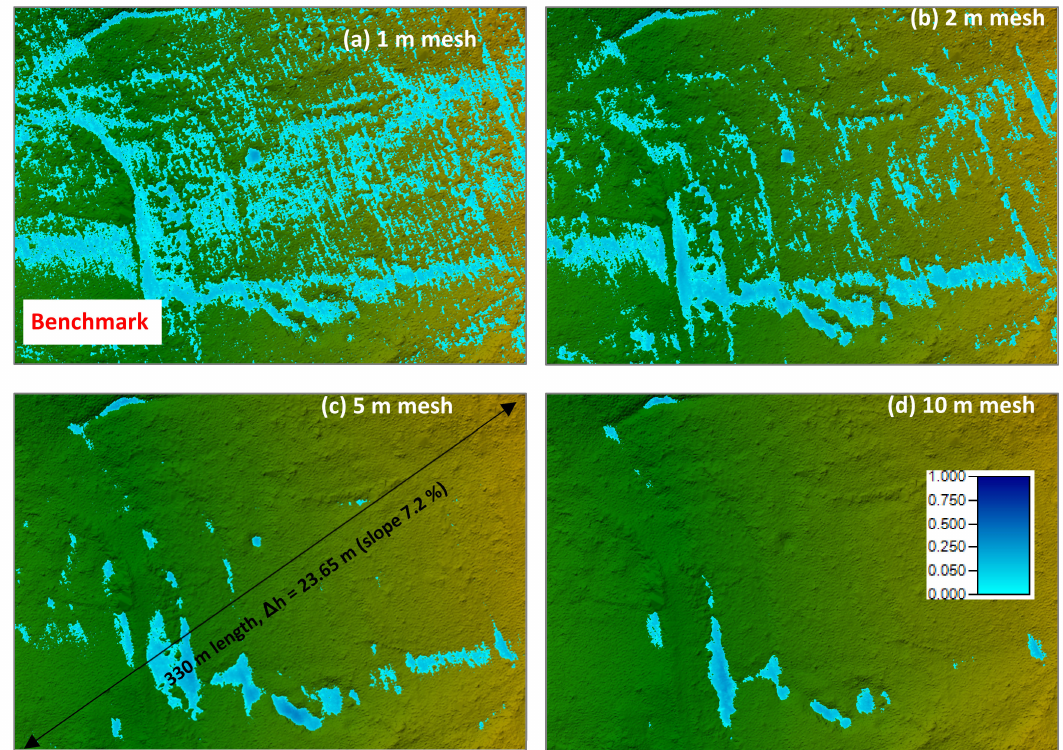
Figure 16. Qualitative comparison of flooded area (max. flood depth during overall simulation time) for four different mesh resolution ( a ): 1 m, ( b ): 2 m, ( c ): 5 m, ( d ): 10 m and 0.25 m